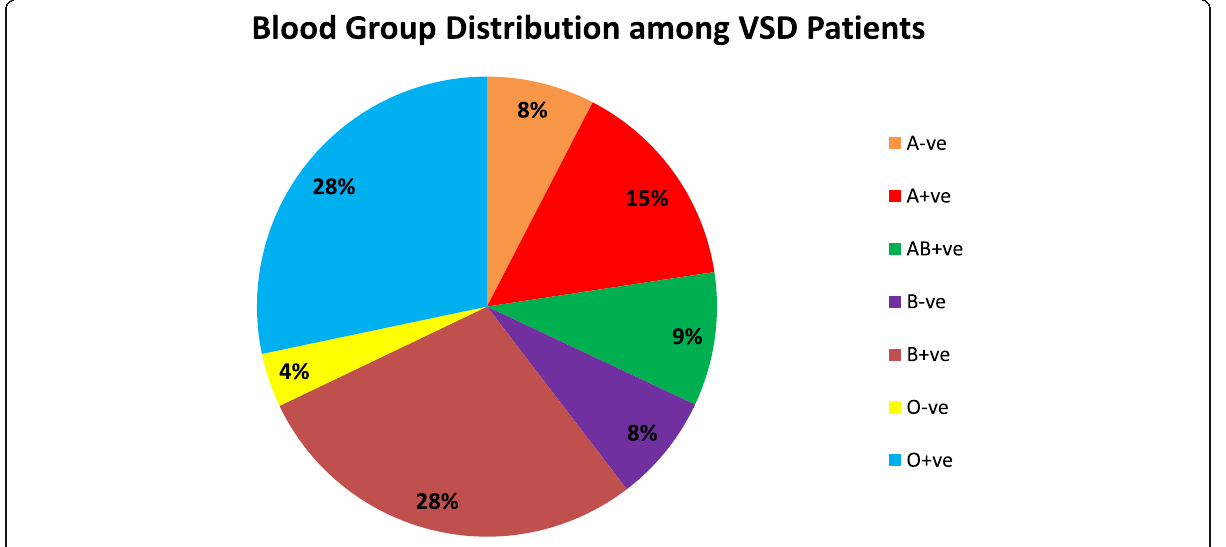
Fig. 1 Blood group distribution among VSD